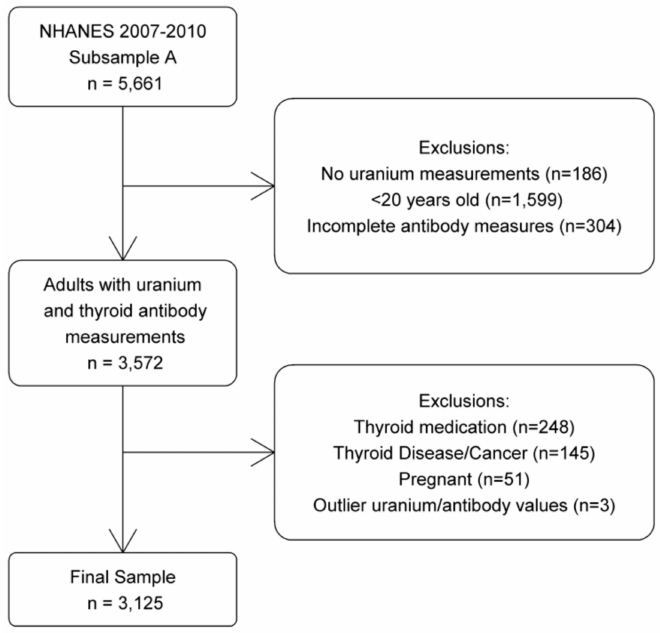
Figure 1. Selection